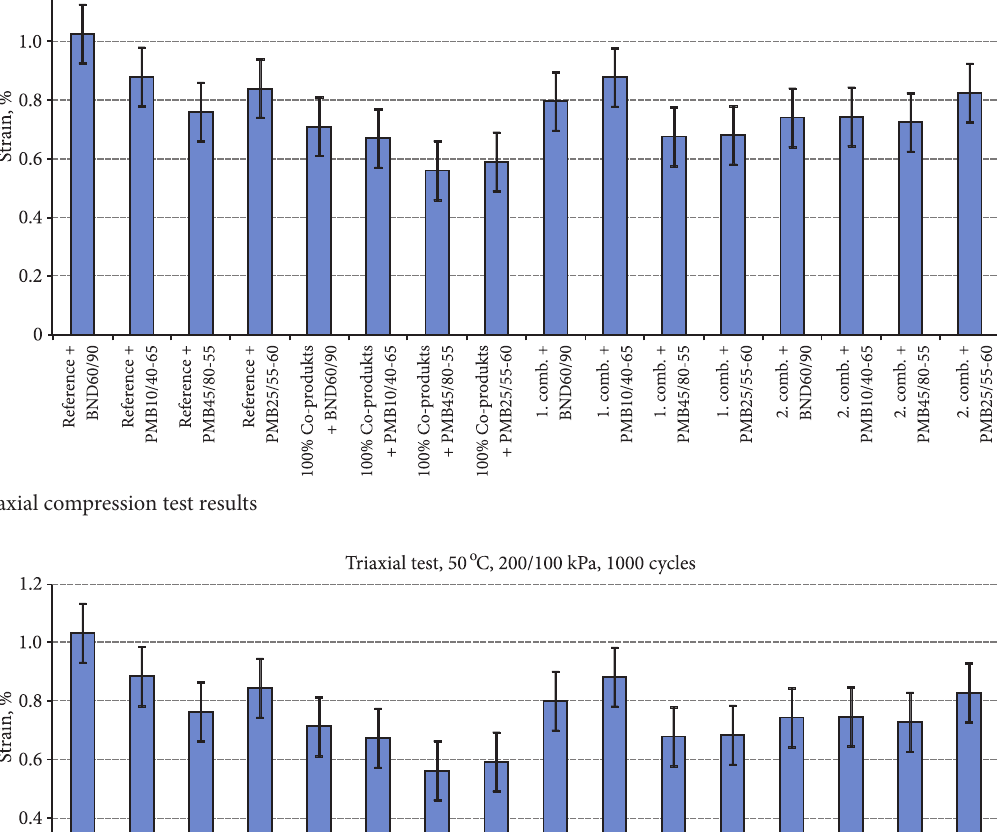
fig. 4. Triaxial test